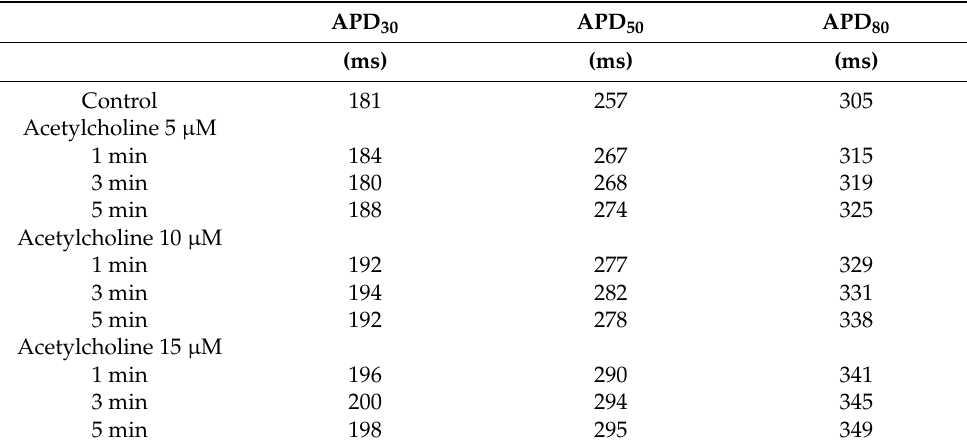
Table 2. Dose-dependence of ACh-induced increase in action potential duration in a human myocar- dial slice preparation at pacing cycle length of 1000